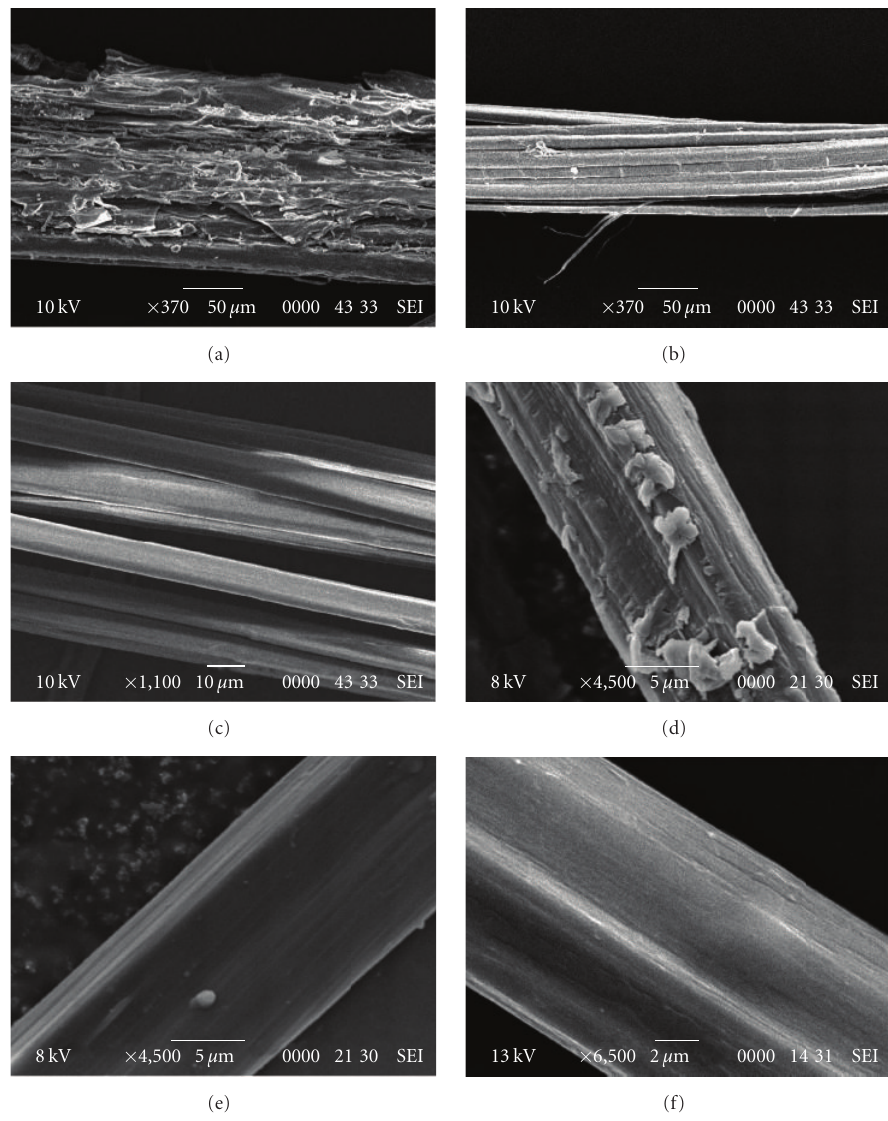
Figure 1: SEM imagesof flax fibres: (a) raw flax bundle, (b) 10% NaOH-treated bundle, (c) 18 H Enzyme-treated bundle, (d) raw elementary fibre, (e) 10% NaOH-treated elementary fibre, and (f) 18H enzyme-treated elementary fibre.